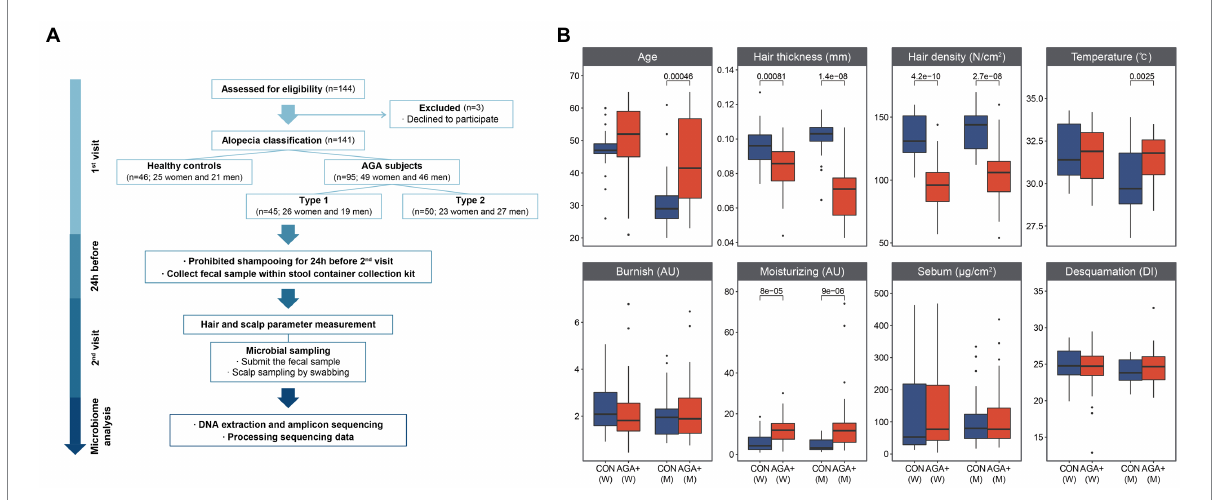
FIGURE 1 Study design and comparison of hair and scalp parameters between healthy controls (CON) and individuals with AGA (AGA+). (A) Flow of the study design. (B) Differences between CON and AGA+ with respect to hair and scalp parameters. W and M are abbreviations for women and men,